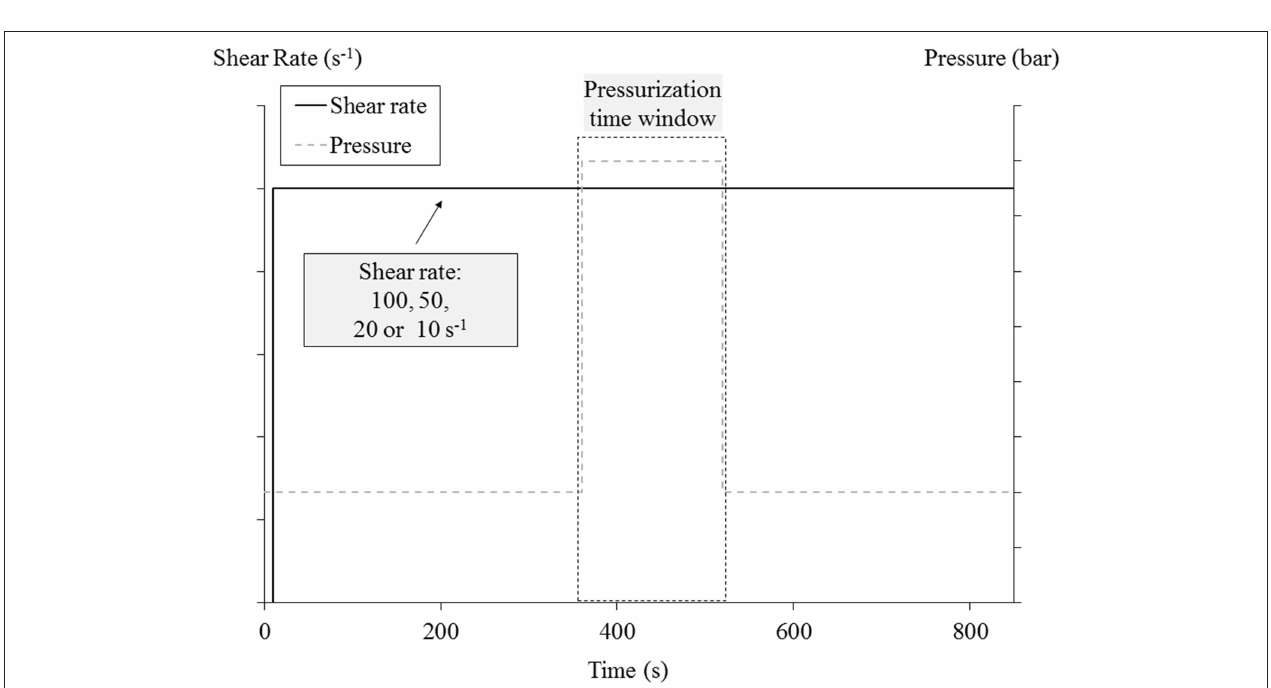
FIGURE 3 | Procedure B imposed a constant shear rate during the test. Different tests had different constant values of shear rate. Pressure was applied in one single step during pressurization window. similar to solid particles amplifying the rheology of suspensions and 0.645, respectively, for bubbles sizes < 500 µ m. Therefore, a (Krieger, 1972). One caution about the results is that the AVA- large majority of the air bubbles behaved mostly as solid particles and had the tendency to amplify the rheological properties, 3000 software is not designed to measure the air-void distribution